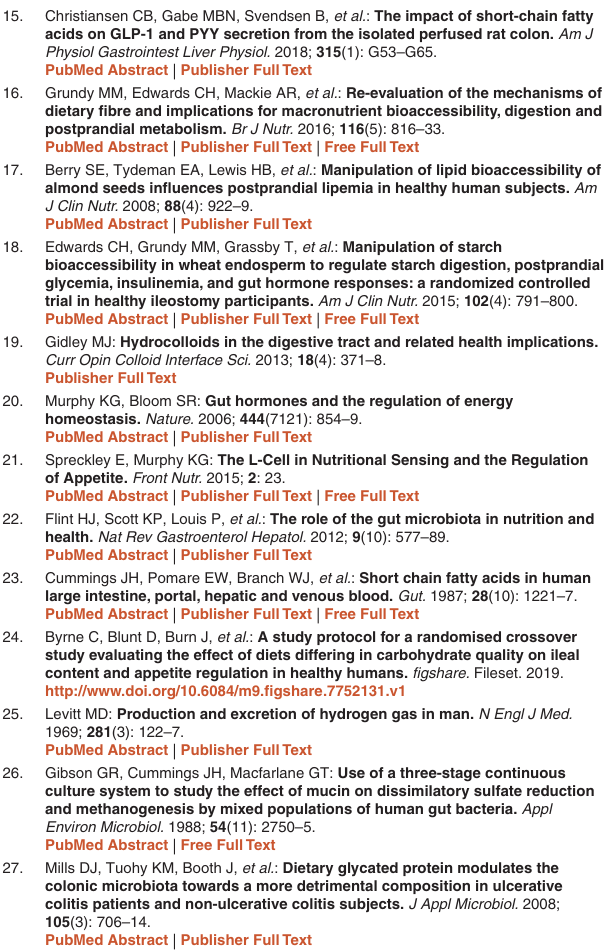
Figshare: SPIRIT checklist for “A study protocol for a randomised crossover study evaluating the effect of diets differing in carbo- hydrate quality on ileal content and appetite regulation in healthy humans”. https://doi.org/10.6084/m9.figshare.7752131.v1 24